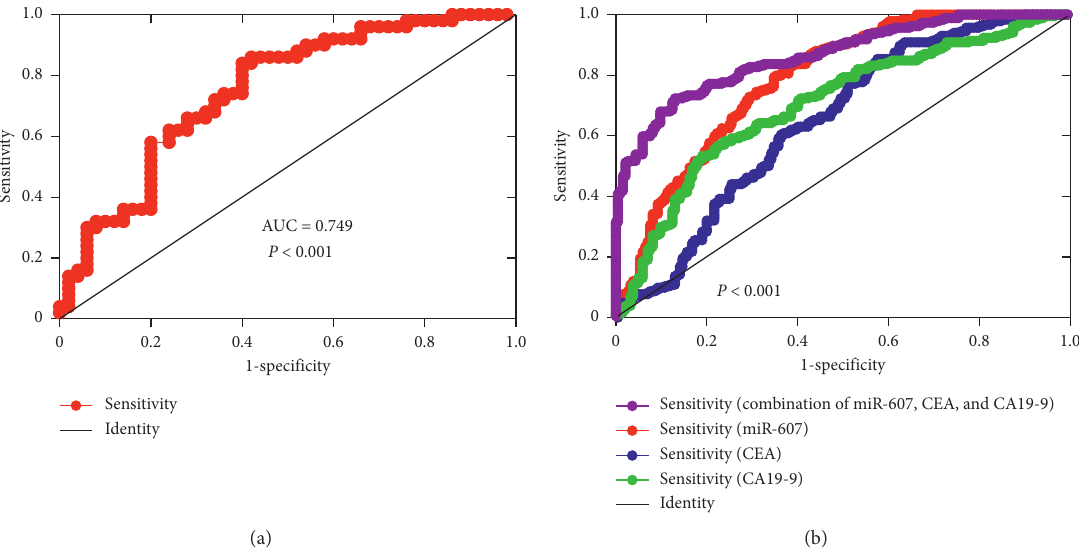
Figure 2: The diagnostic value of miR-607 in patients with PDAC. (a) ROC curve analysis of miR-607 expression for discriminating PDAC tumor tissues from normal tissues. (b) ROC curve analysis based on serum miR-607, CA19-9, CEA, and their combination for differ- entiating PDAC patients from healthy controls. ROC: receiver operating characteristic, AUC: area under the